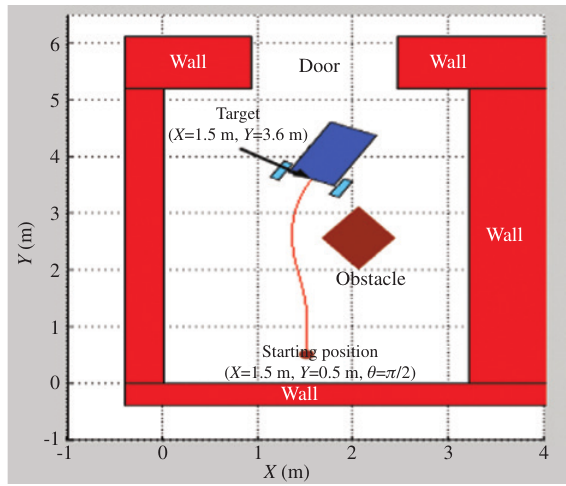
Figure 14: Experimental Result of Obstacle Avoidance.